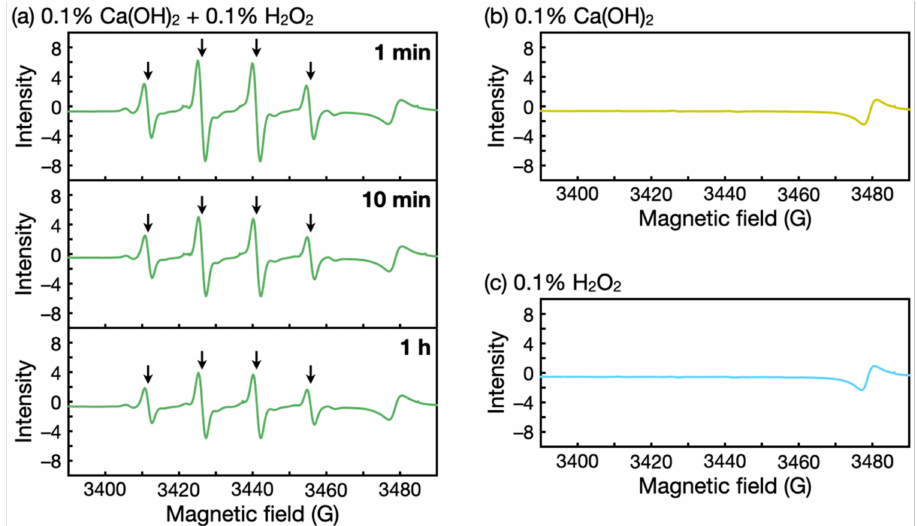
Figure 6. ESR spectra of ( a ) Ca(OH) 2 –H 2 O 2 solutions, ( b ) Ca(OH) 2 solutions, and ( c ) H 2 O 2 solutions. The arrows in ( a ) indicate characteristic signals of HO ·